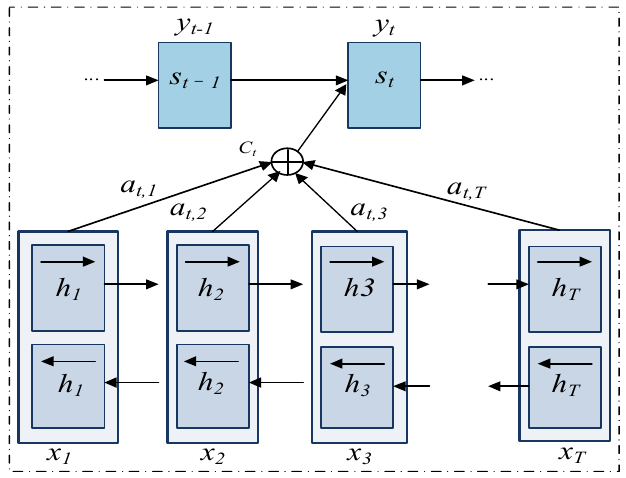
Figure 5. The structure of attention mechanism.